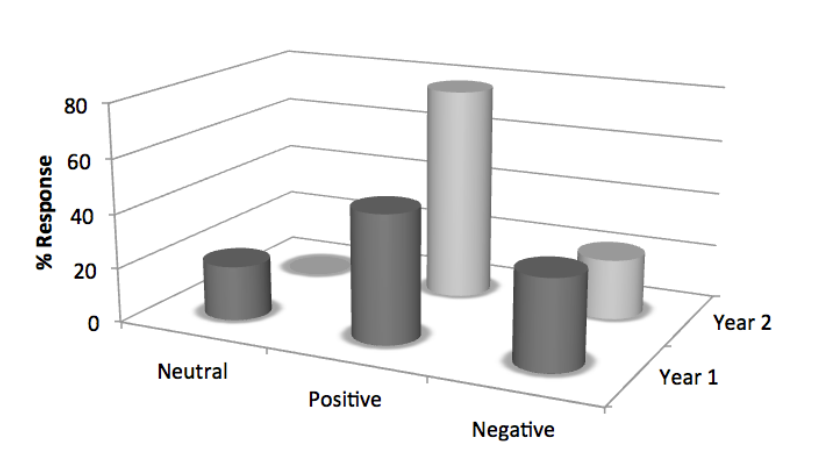
Figure 3: Comparative chart depicting the perceived impact (neutral, positive or negative) on learning in a NearPod class. Year one cohort (n=30), Year Two cohort